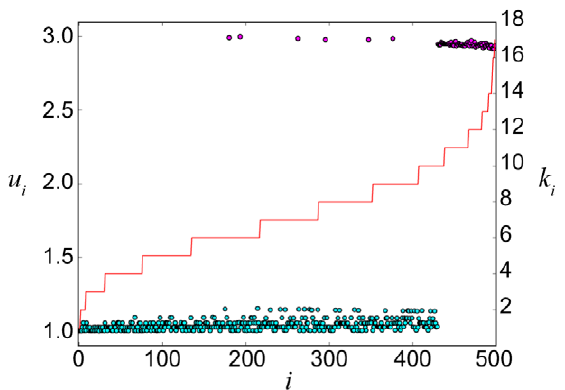
Figure 3. Nodes activation levels for a stationary pattern in an Erdo¨s-Re´nyi network. Dependence of the activation level u i on the degrees k i of the nodes i is presented for a stationary pattern in the ER network of size N ~ 500 and mean degree S k T ~ 7 . The nodes are ordered according to their increasing degrees, shown by the stepwise red curve. The other parameters are r 1 ~ 1 , r 2 ~ 1 : 4 and r 3 ~ 3 ; the diffusion constant is D ~ 0 : 01 .